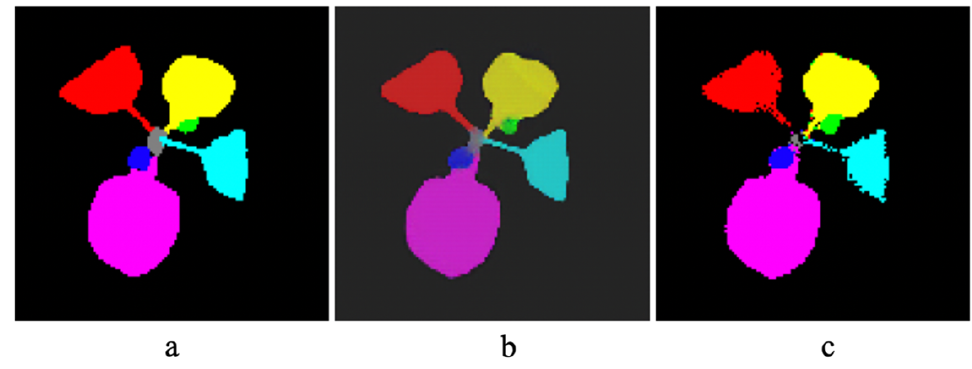
Figure 7. A comparison between a predicted frame and its processed image. ( a ) Ground truth. ( b ) Predicted frame. ( c ) Processed prediction frame.